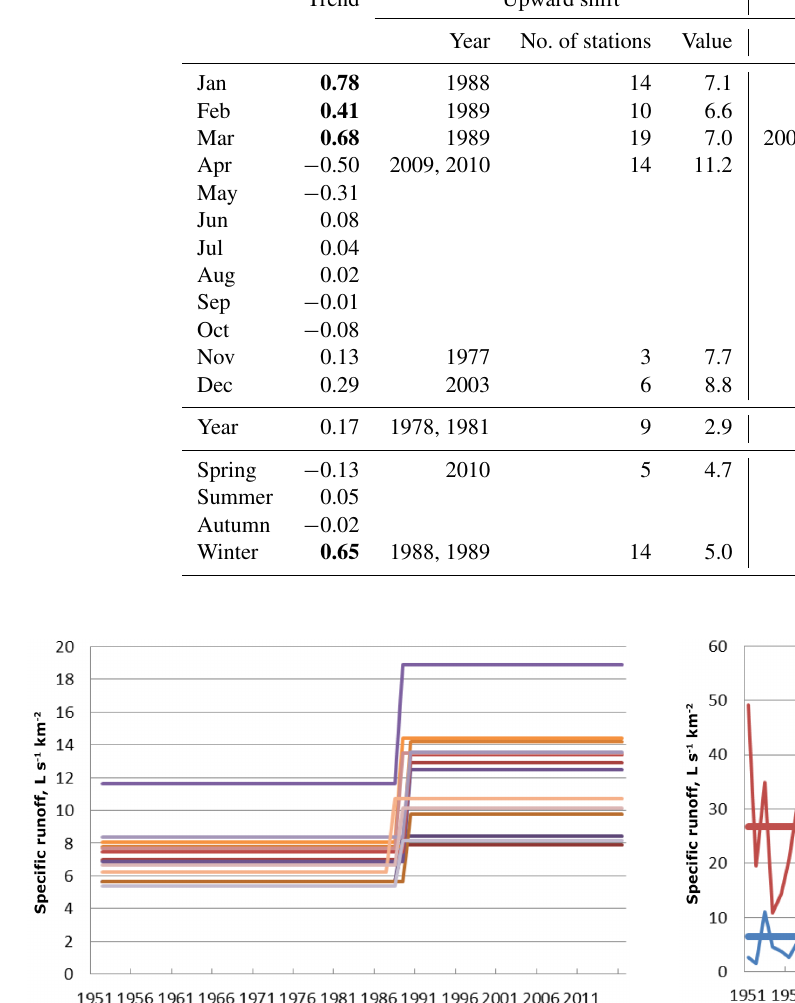
Figure 3. Time series of specific runoff (Ls 1 km − 2 ) in March (blue) and April (red) at Riisa station on the Halliste River during 1951–2015 and their regime shifts of opposite sign since 1989 and 2009 (wide